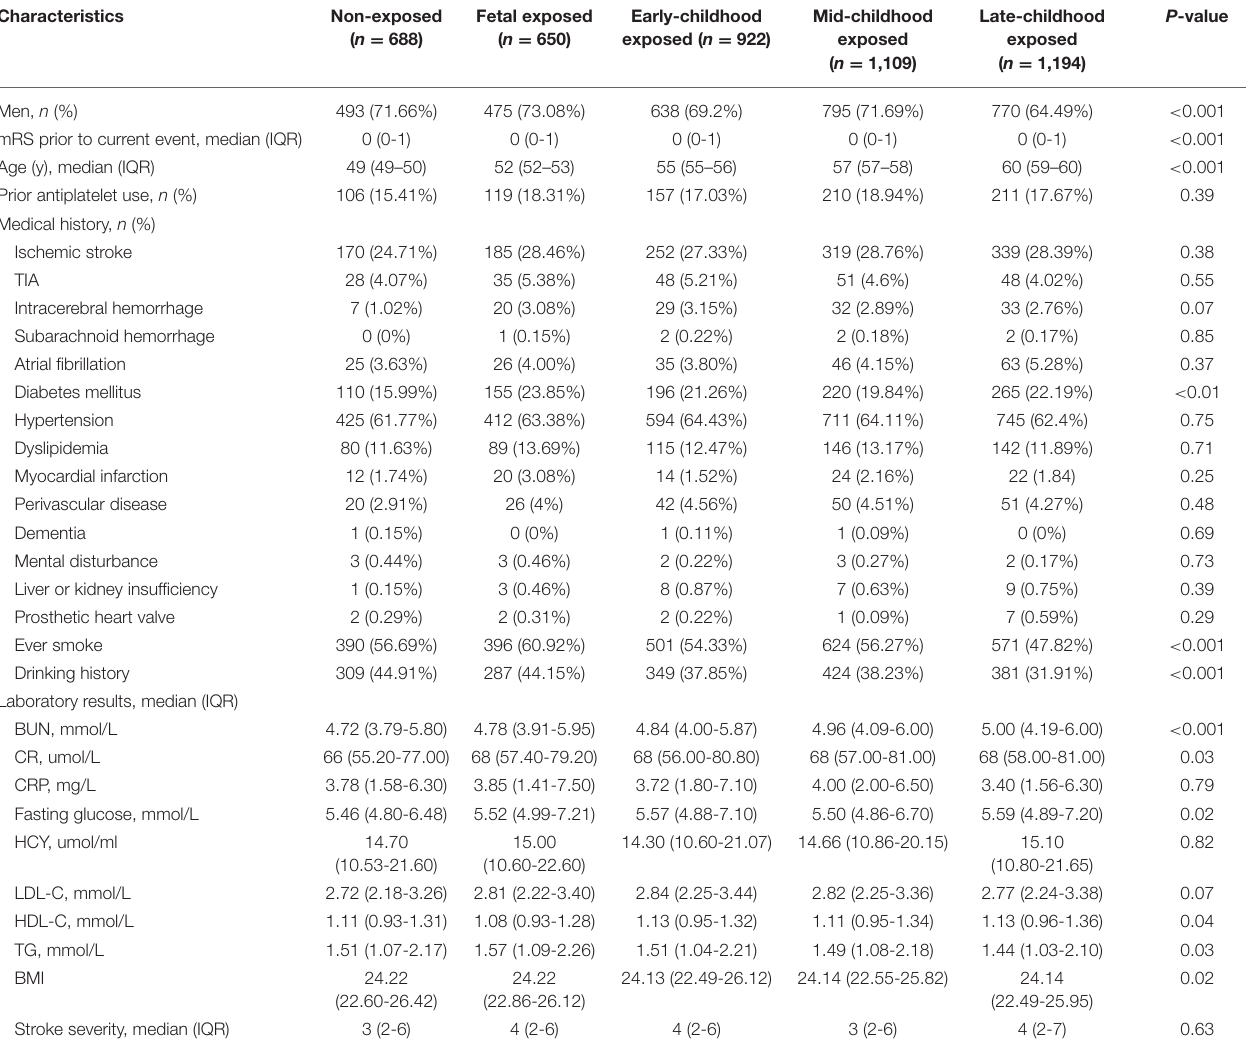
TABLE 1 | Baseline characteristics of included participants by different life phase of early age when exposed to the Chinese